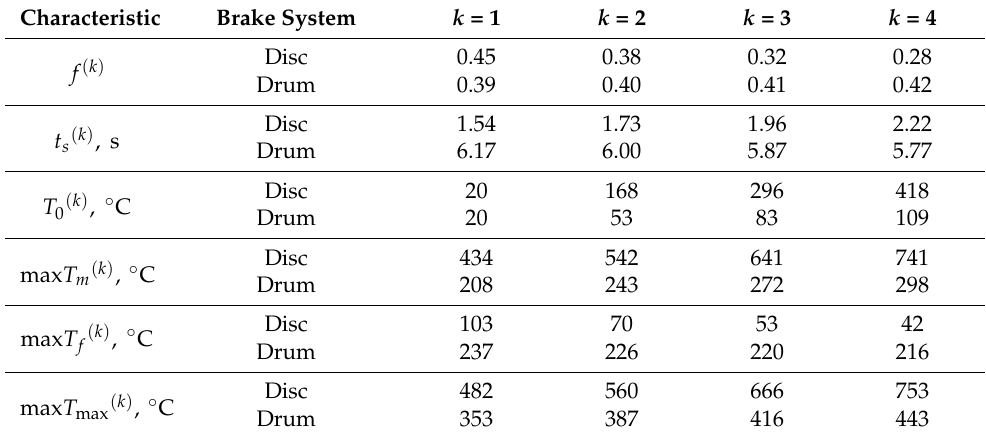
Table 3. Calculated values of some characteristics at each braking cycle.